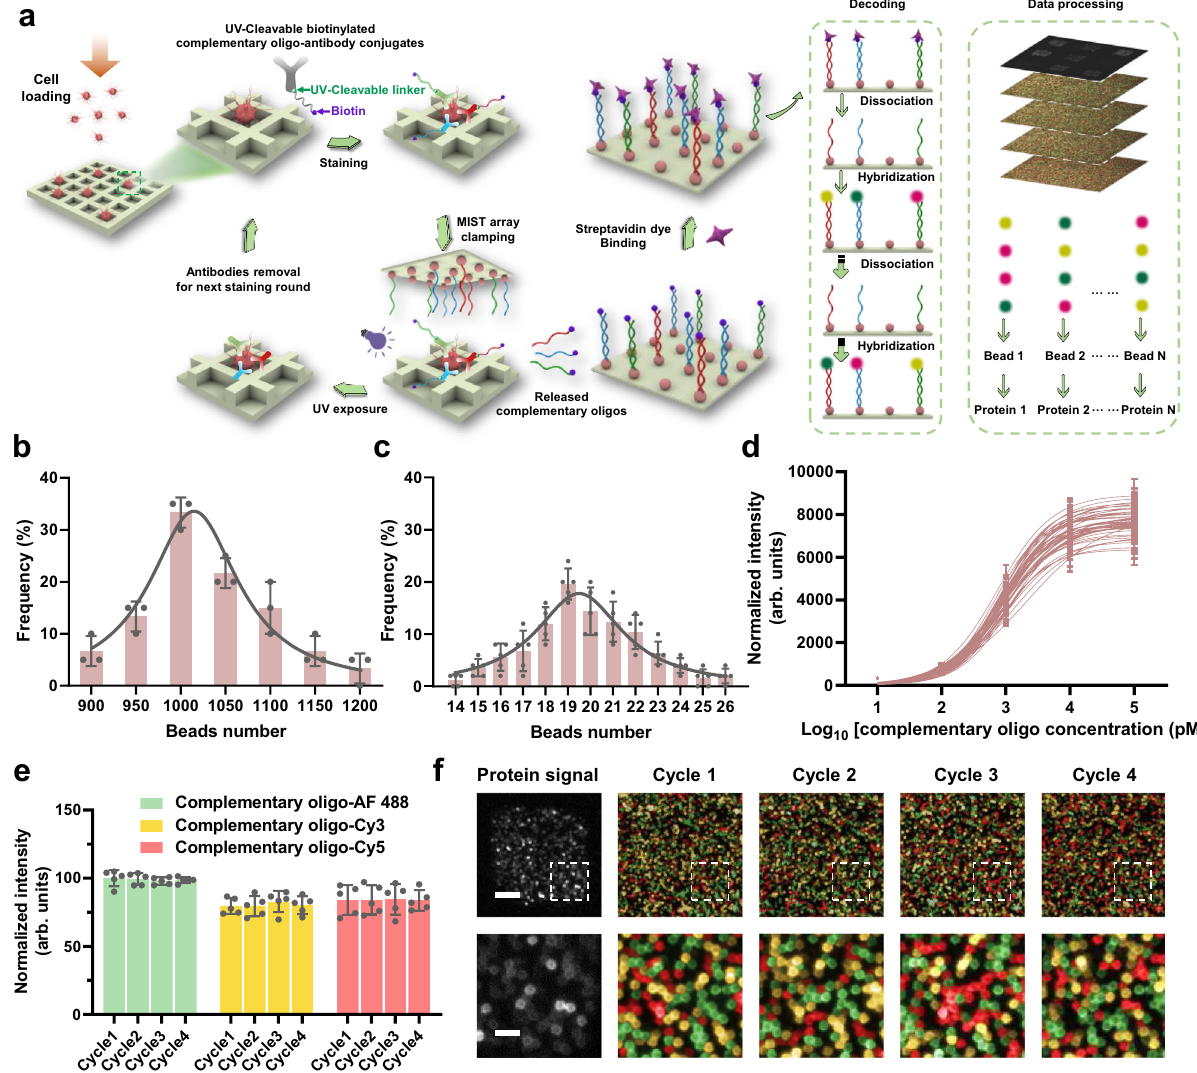
Fig. 1 Overview of CycMIST technology for single-cell functional proteome analysis. a Schematic illustration of the CycMIST process to analyze multiple proteins through the MIST microbeads array. b Distribution of the number of oligo DNA-coated microbeads on each 75 μ m × 75 μ m area of a MIST array that is corresponding to a PDMS microwell, n = 3 independent MIST array. c Distribution of the number of same kind oligo DNA-coated microbeads on the same MIST array, n = 5 independent MIST array. d Characterization of the CycMIST sensitivity by varying the concentrations of 50 biotinylated complementary oligo DNAs on the MIST array, n = 10 independent experiments. This is the same procedure in single-cell protein detection experiments except cell loading and conjugate binding. e Consistency of fl uorescence intensities for 4 decoding cycles and for 3 fl uorescent color dyes (Alexa Fluor 488, Cy3 and Cy5), n = 5 independent experiments. f Sample images of multiplexed assay of 50 proteins from a single cell by CycMIST and the 4 decoding cycles images. The greyscale images are protein detection result, and the color images are the decoding cycles from cycle 1 to cycle 4. The bottom panel is the zoom-in images from the squares in the up panel. Scale bar: 20 μ m (up panel); 5 μ m (bottom panel). Data are presented as mean values ± SD of more than three independent experiments, and error bars are within symbol size if not shown. The term (arb. units) is abbreviated for arbitrary